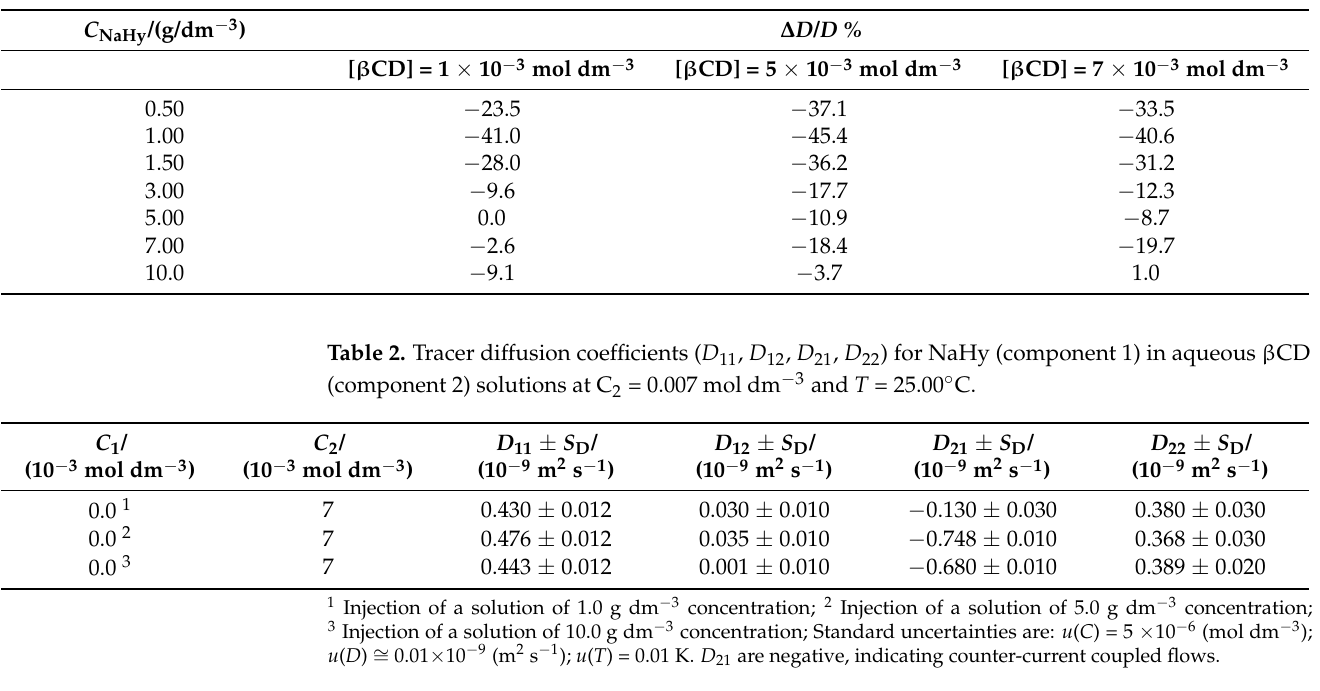
Table 1. Relative deviations ( ∆ D / D %) between tracer diffusion coefficients of NaHy in aqueous solutions containing β CD and tracer diffusion coefficients of NaHy in water.